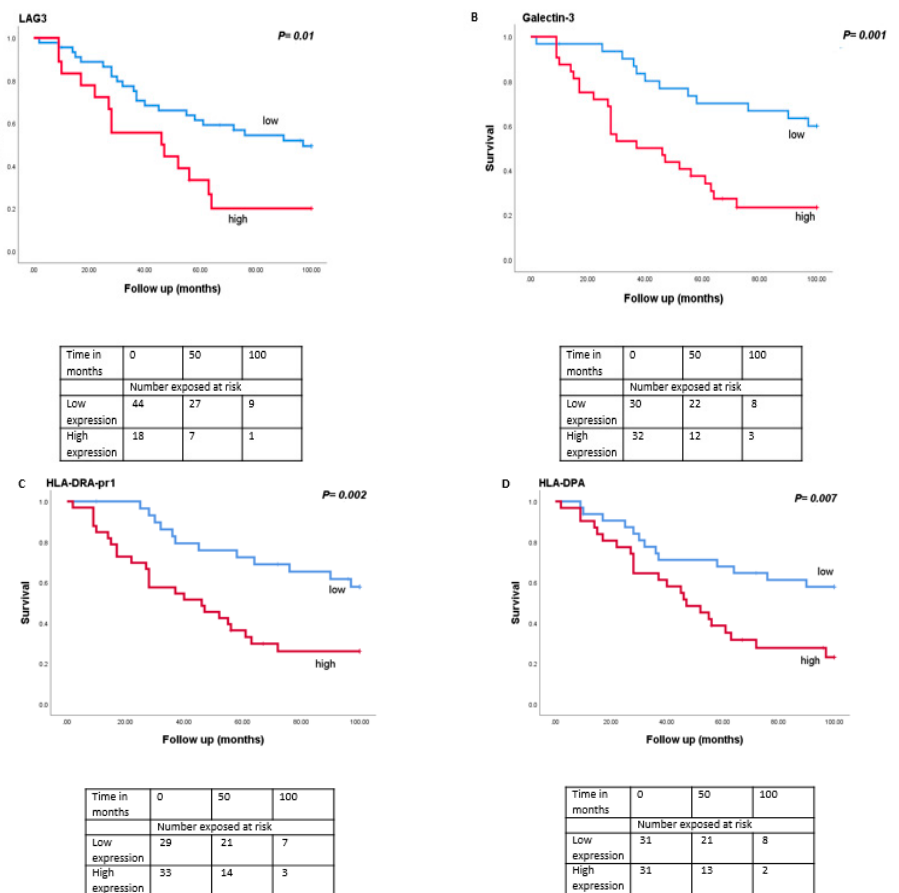
Figure 4. Kaplan-Meier survival curves based on mRNA expression of LAG3 , Galectin-3 , and HLA class II molecules. A log- rank test was used for statistical testing. p ≤ 0.05 is considered significant ( A ): LAG3 , ( B ): Galectin-3 , ( C ): HLA-DR -probe 1, ( D ): HLA-DPA